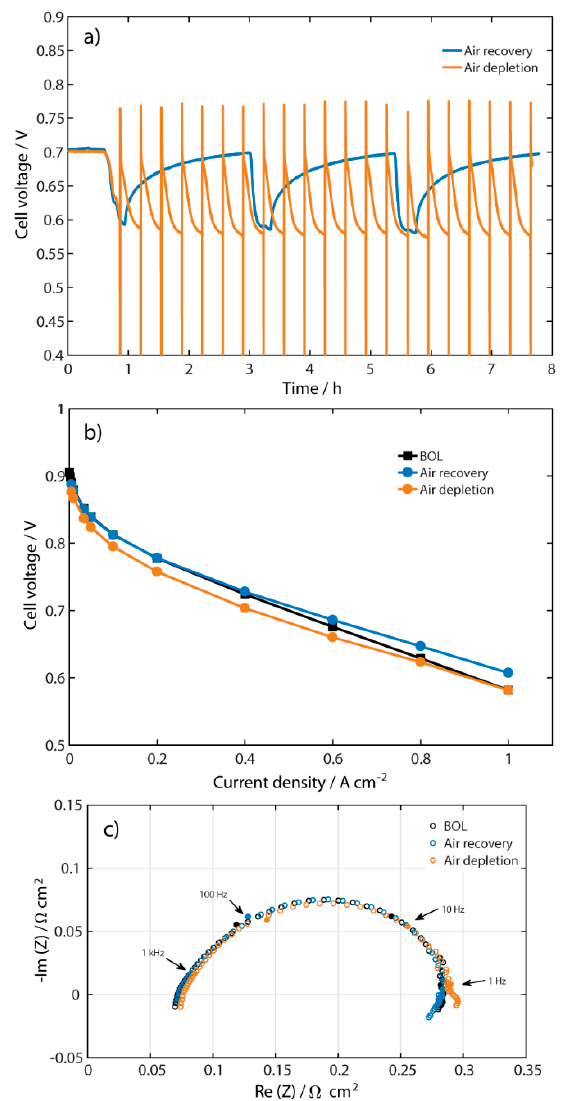
Figure 5. ( a ) Transient cell voltage when introducing 50 ppm NO 2 to the cathode air flow at 0.5 A cm − 2 for two different strategies, namely air recovery (blue) and air depletion (orange); ( b ) polarization curves; and ( c ) galvanostatic EIS measurement at 0.5 A cm − 2 at BOL and after testing the two strategies.